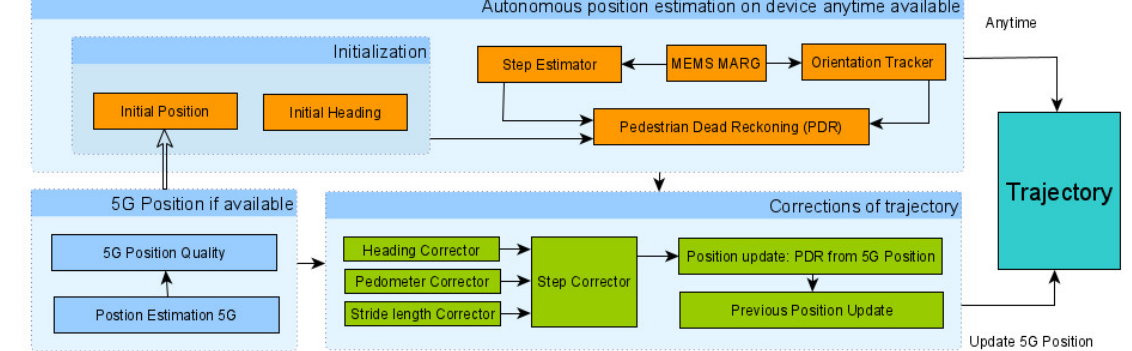
Figure 8. The fusion concept of PDR and 5G in both online and offline modes.